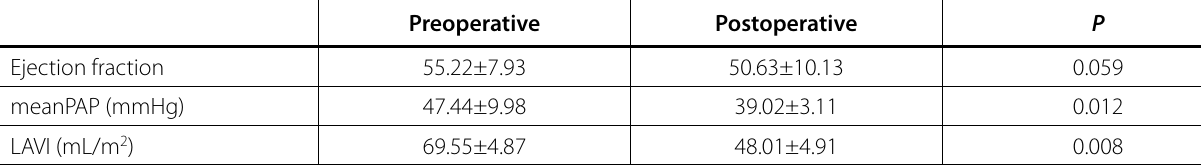
Table 3 . Statistical analyses of echocardiographic datas.